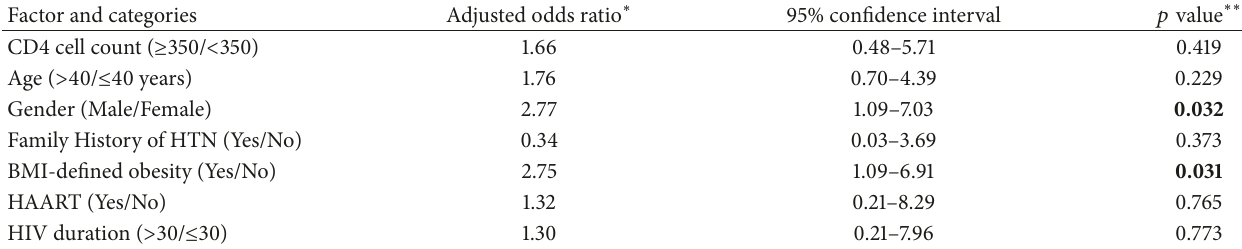
Table 5: Association between CD4 cell count and hypertension after controlling for confounders.